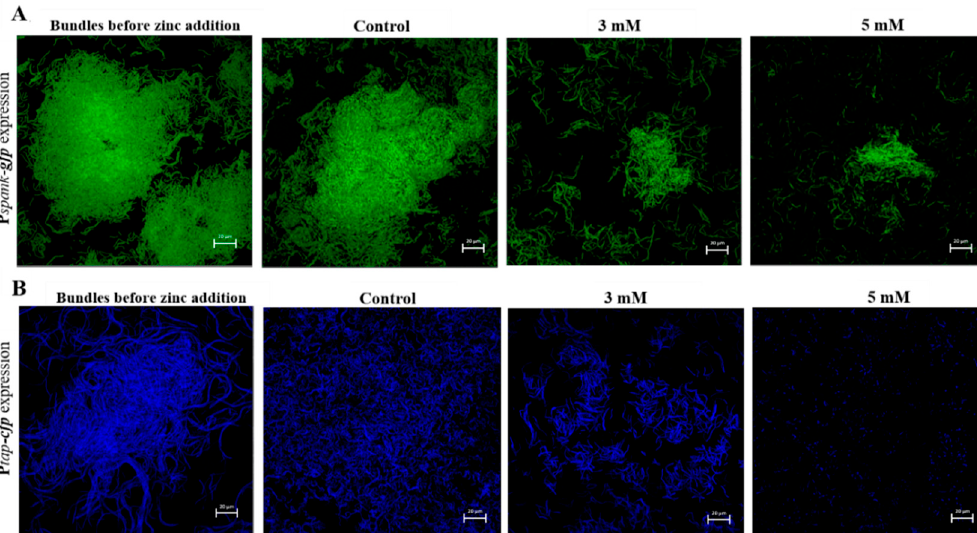
Figure 3. Antimicrobial effect of Zn 2+ ions against B. subtilis biofilm bundles. Addition of zinc to the medium efficiently disrupted biofilm bundles formed overnight. Demonstrated in CLSM images of two fluorescently tagged B. subtilis strains: constitutively GFP producing (P spank ‐ gfp) ( A ) and tapA promotor related CFP producing (P tap ‐ cfp ) ( B ) following 17 h incubation in LB supplemented with 3% lactose at 23 °C (with 50 rpm shaking), prior to zinc addition, and additional 5 h incubation in presence of ZnCl 2 . Scale bar—20 μ m.